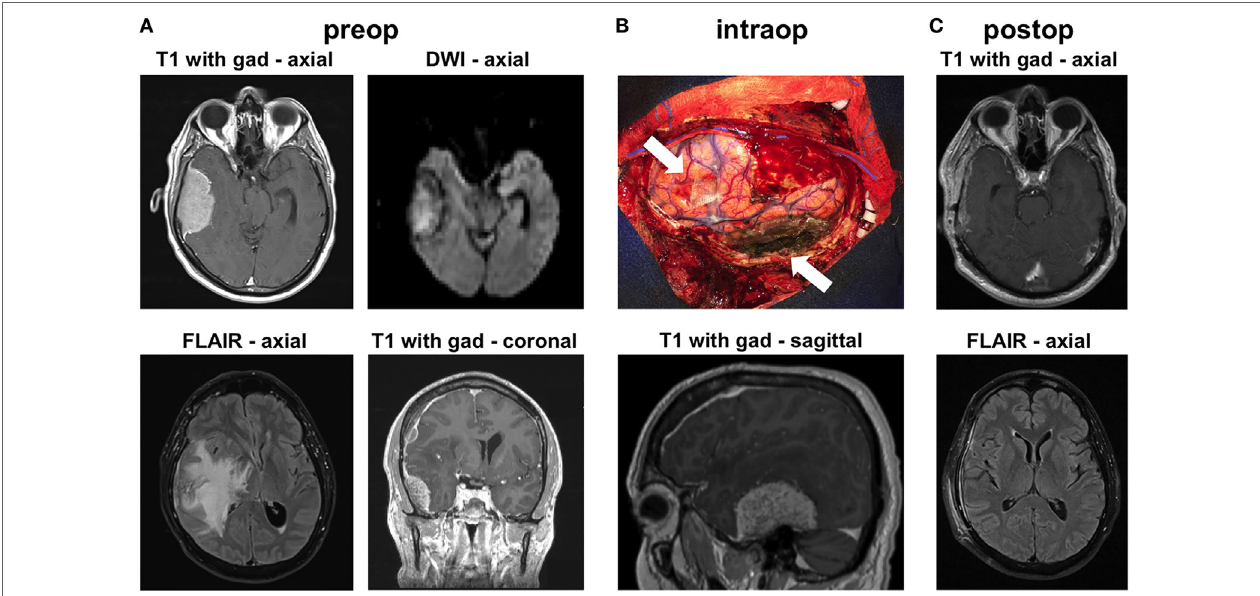
FiGURe 1 | Radiographic findings. (A) Preoperative MRI shows contrast-enhancing extra-axial masses in the right temporal and frontal regions. The temporal mass shows diffusion restriction on diffusion-weighted imaging (DWI) imaging. There was substantial vasogenic edema within a large territory of the right hemisphere on FLAIR images. (B) Intraoperative image shows the areas of the two masses (arrows), after their resection. The image is shown in conjunction with a preoperative sagittal MRI image that highlights the location of the large temporal mass. (C) MRI 6 weeks after surgery shows no recurrence and resolution of the vasogenic edema on FLAIR